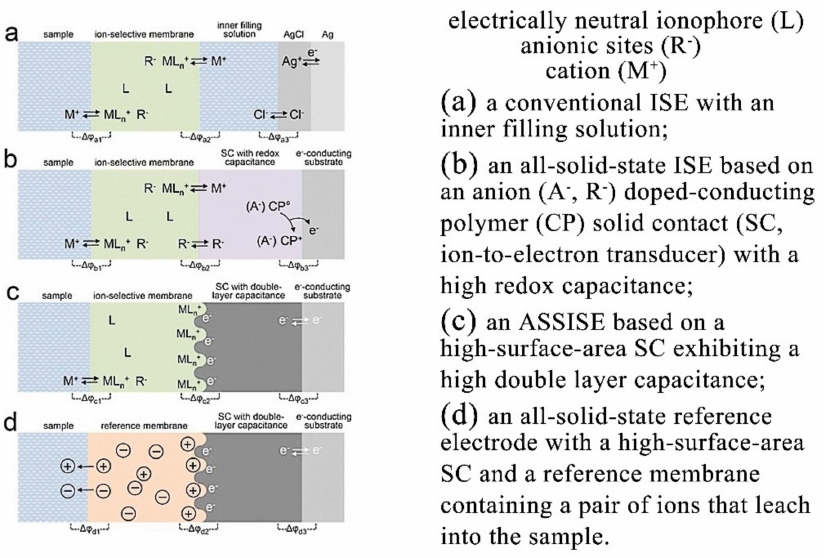
Figure 2. The schematic diagram of the ASSISE transduction mechanism. “Reprinted/adapted